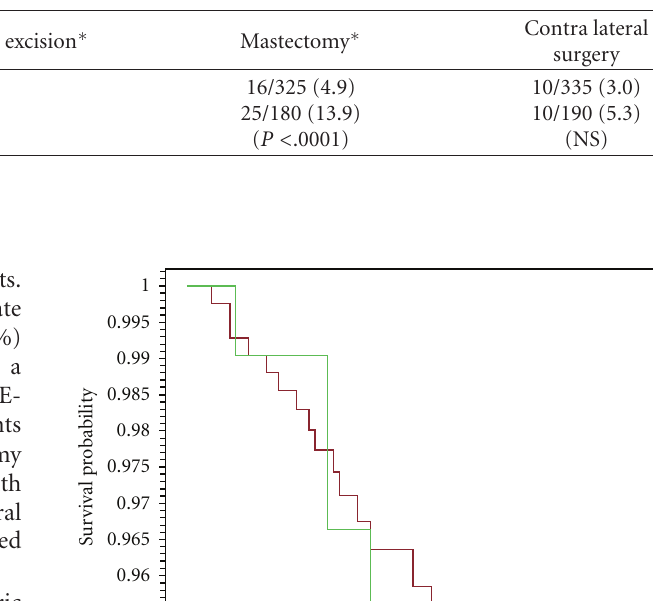
Table 6: Negative versus positive nodes in the subgroups.